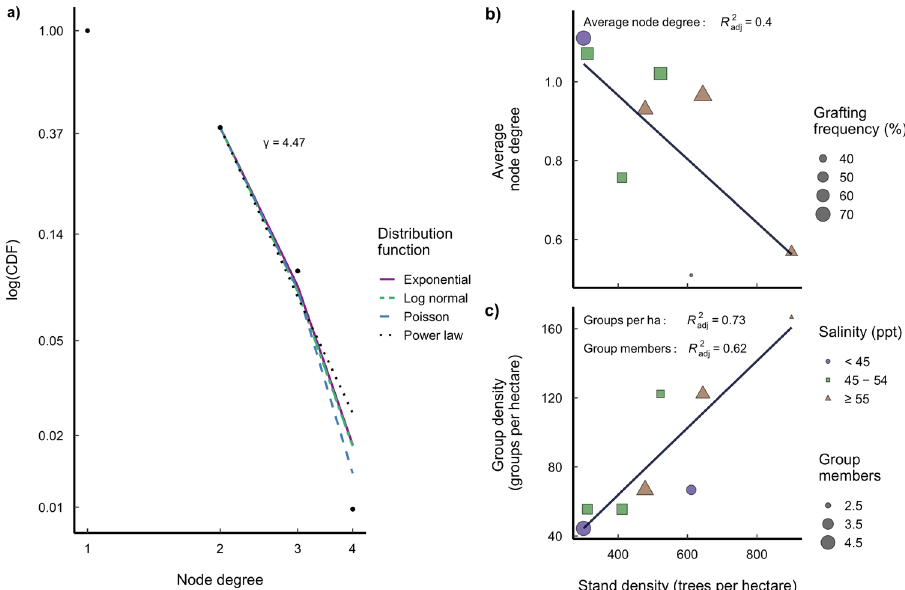
Fig. 3 Root graft network attributes. a Comparison of log-transformed cumulative distribution functions (CDF). The number of direct connections for a given tree (node degree) shows that root graft networks might fi t a scale-free power-law distribution with a slope γ = 4.47. But with a min. node degree of 2, the Poisson, log-normal and exponential distributions cannot be discarded. b Linear regression showing a reduction on the average node degree of the networks along the A. germinans stand-density gradient and grafting frequency (%). Shape and colour depict the salinity range of the plots (purple circles <45 ppt, green squares 45 – 55 ppt and brown triangles ≥ 55 ppt) and the size of each shape indicates the stand ’ s grafting frequency. c Linear regression showing an increasing number of groups of grafted trees per hectare with signi fi cant reduction in the mean group members (shape size), this is, the number of trees forming a